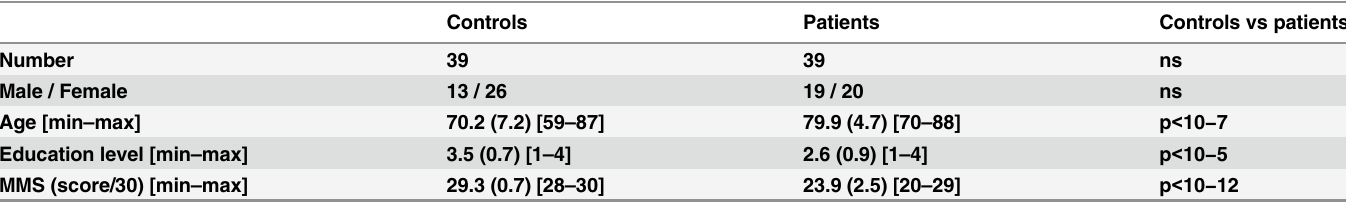
Table 1. Demographical and neuropsychological characteristics of the studied